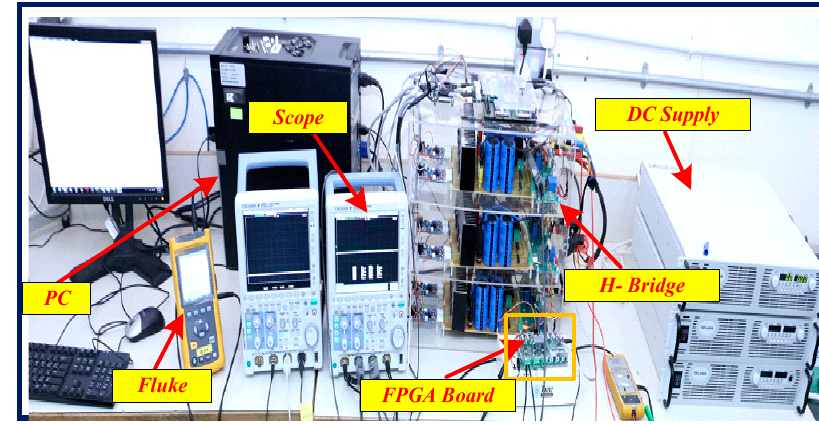
Figure 10. Experimental setup.